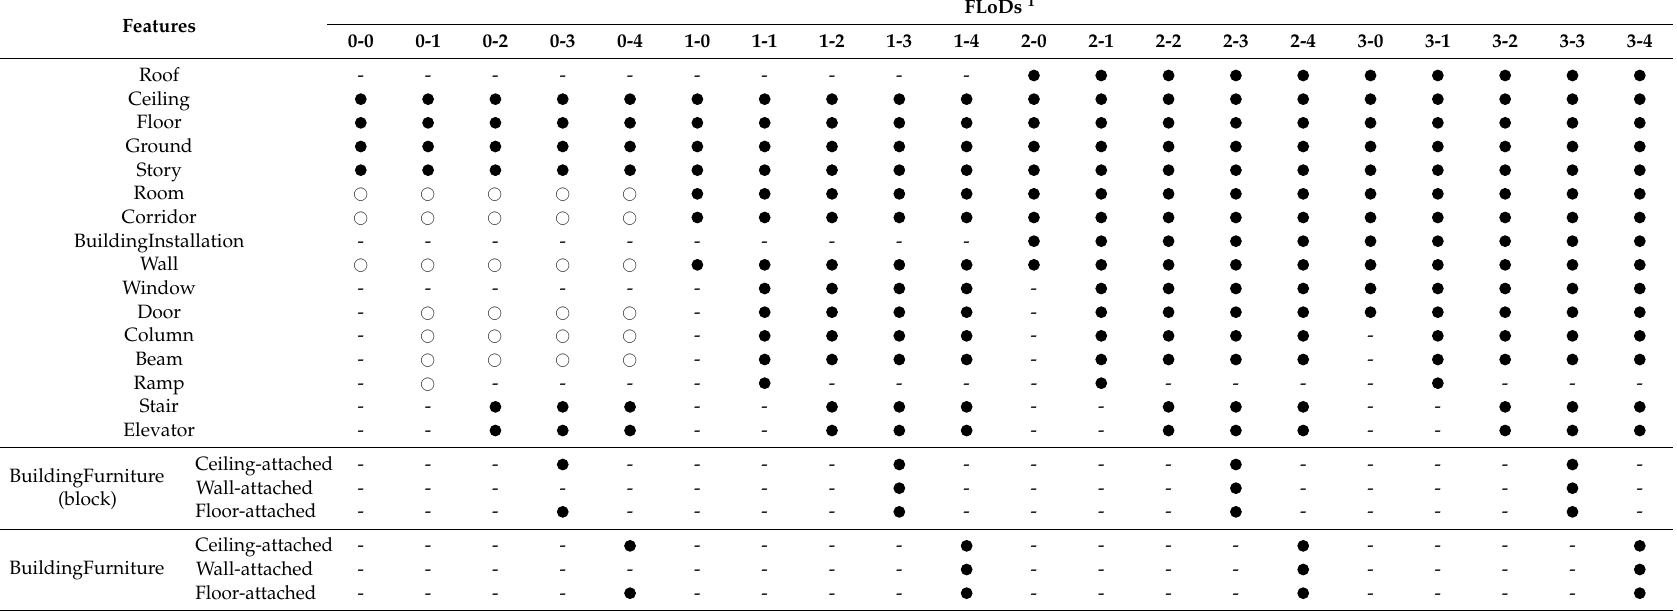
” denotes the feature exists but in the form of